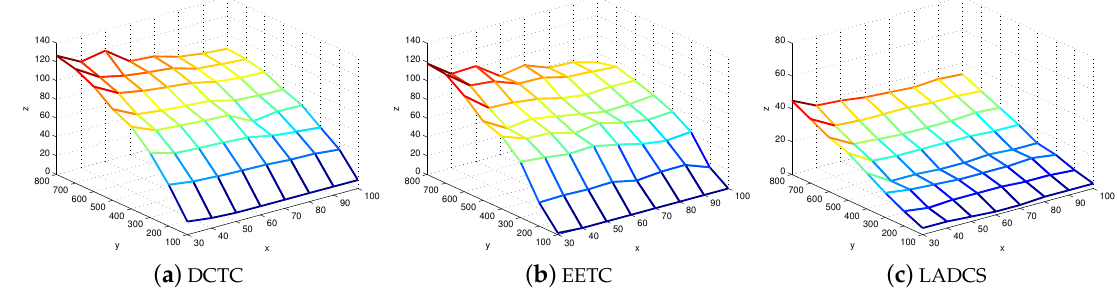
Figure 13. The number of connected cover sets generated in DCTC, EETCand